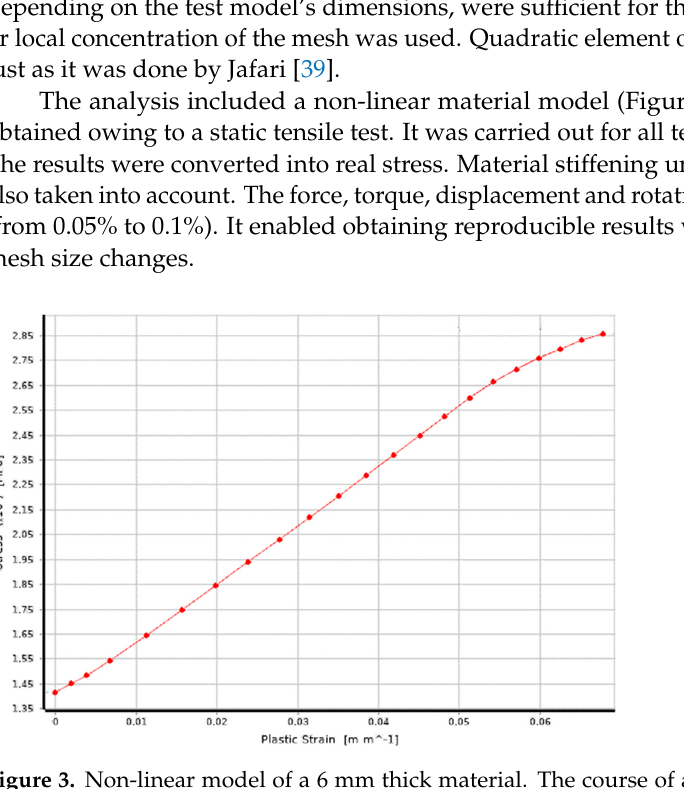
( b ) Figure 4. ( a ): test set expanded by 30 mm. ( b ): test set expanded by 30 mm and twisted by 20°. The prepared model helped to perform numerical tests in the whole planned range. The tested profiles were 3 mm and 6 mm thick and 30 mm to 60 mm broad. They were expanded within the 0–30 mm range with a 5 mm stroke. The maximum twist amounted to 20°. The results obtained for unexpanded sets were compared with the results of ana- lytical calculations. They were characterised by high convergence, ranging from − 3% to +5.5%. It was then assumed that the simulation had been correctly prepared, and the re- sults obtained for the expanded test packages were correct and confirmed by the experi- ment results. 2.3. Experimental Study The developed test stand enabled obtaining reproducible measurement results at a short duration of a single set’s test. It consists of five essential assemblies, shown in Figure 5a.